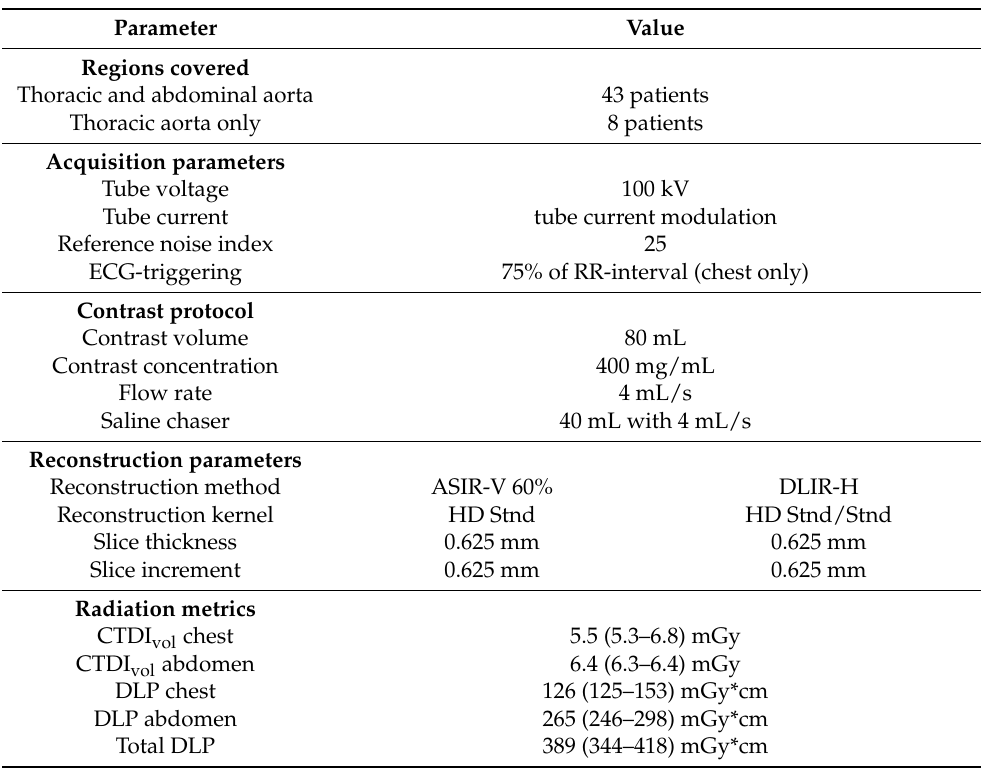
Table 1 data are shown as the median (25–75 percentile) for DLP and CTDI vol . ASIR-V = adaptive statistical iterative reconstruction V, DLIR-H = deep-learning-based reconstruction–high strength, CTDI vol =